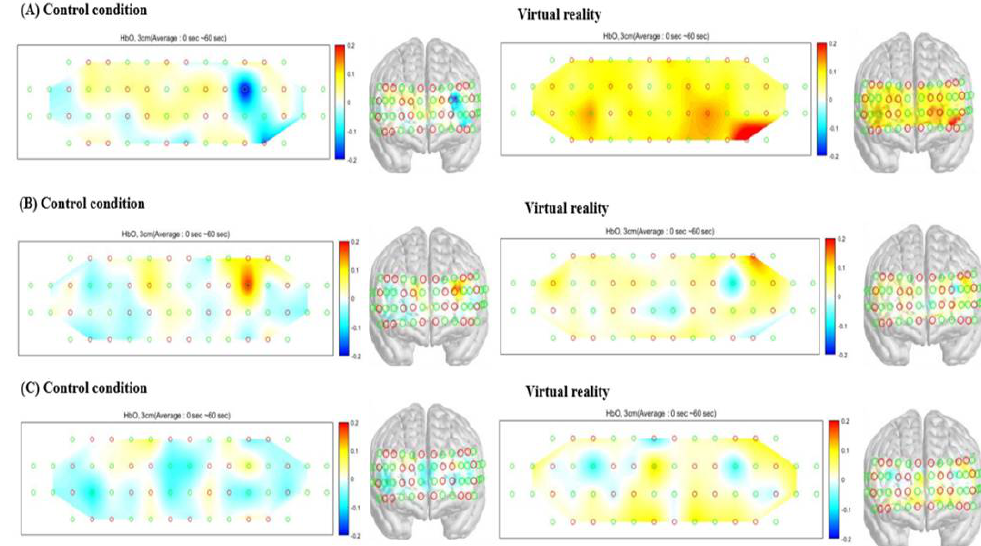
Figure 4. Reconstructed DOP images of HbO 2 . ( A ) Data from day 1, ( B ) data from day 5, and ( C ) data